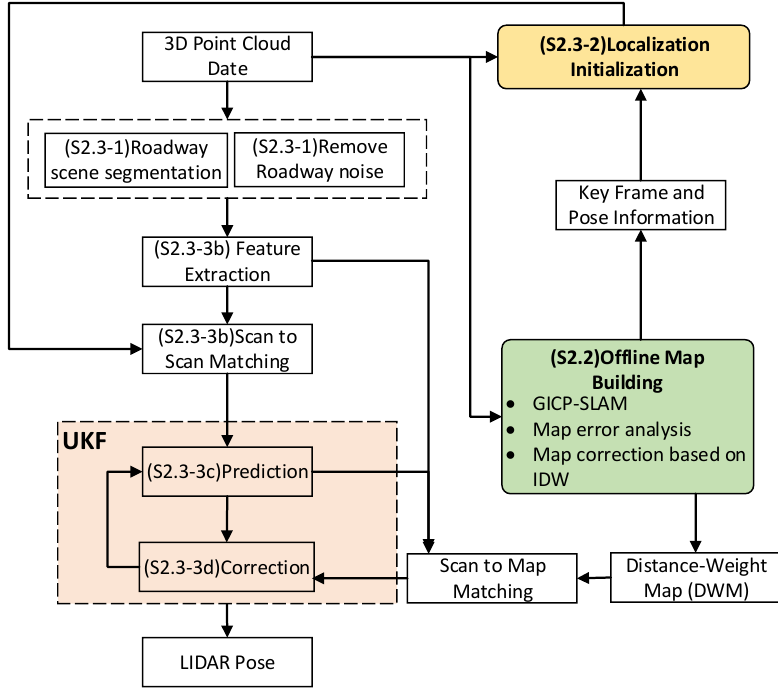
Figure 1. Distance-weight map localization system flow.